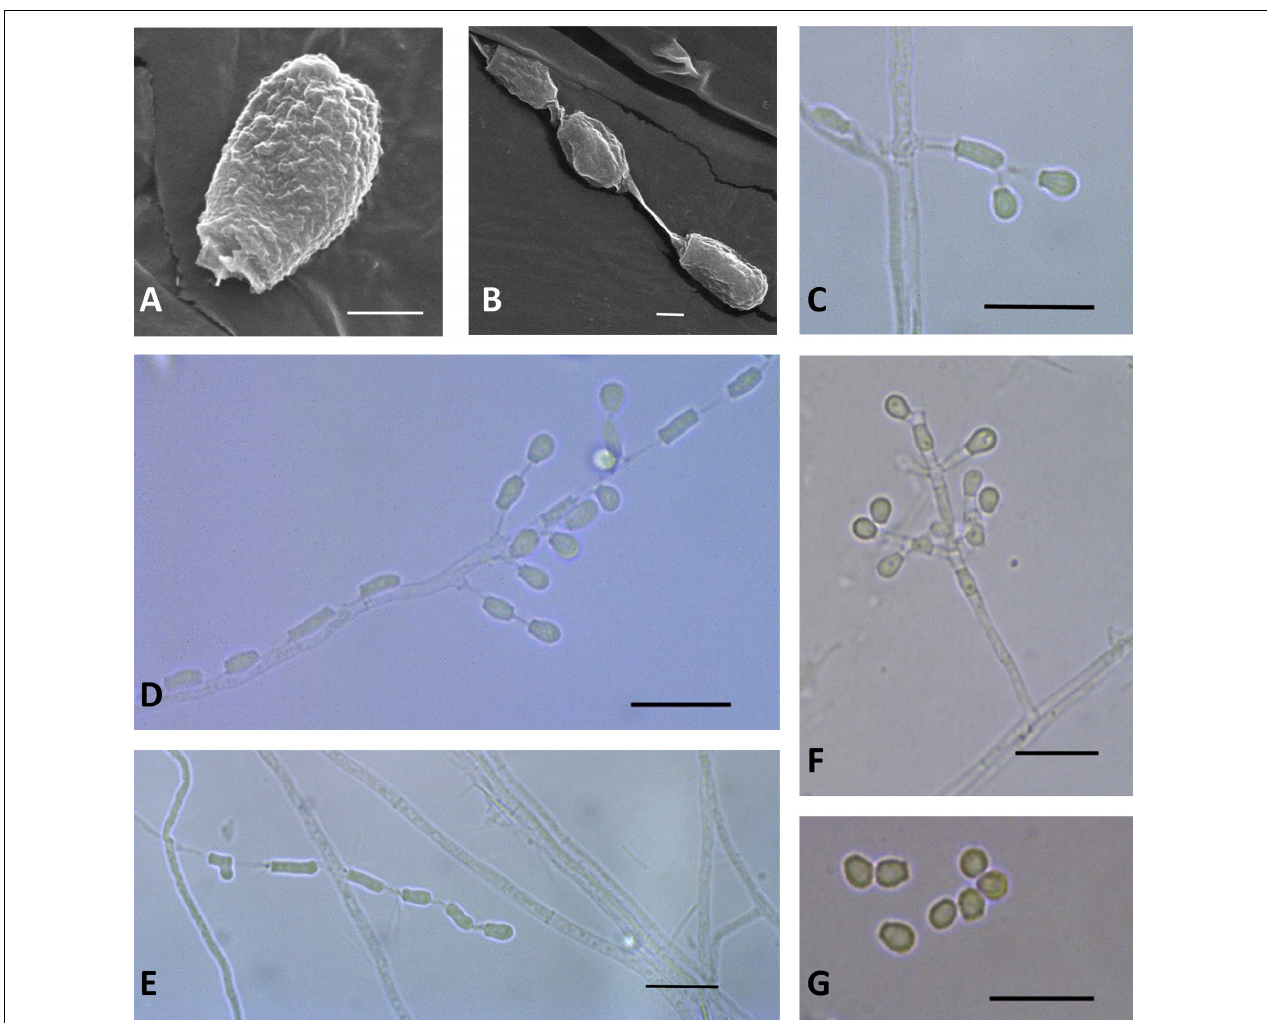
FIGURE 3 | Microscopic analysis of Pseudogymnoascus antarcticus sp. nov. Conidium (A) ; Fertile hyphae bearing arthroconidia and aleurioconidia, sessile, or stalked (B,C,D,E) ; Conidiophore (F) ; Conidia (G) . In panels (A,B) , the structures were observed using transmission electron microscopy, while in panels (C–G) , light microscopy was used. Scale bars = 1 µ m (A,B) , 10 µ m (C–G)